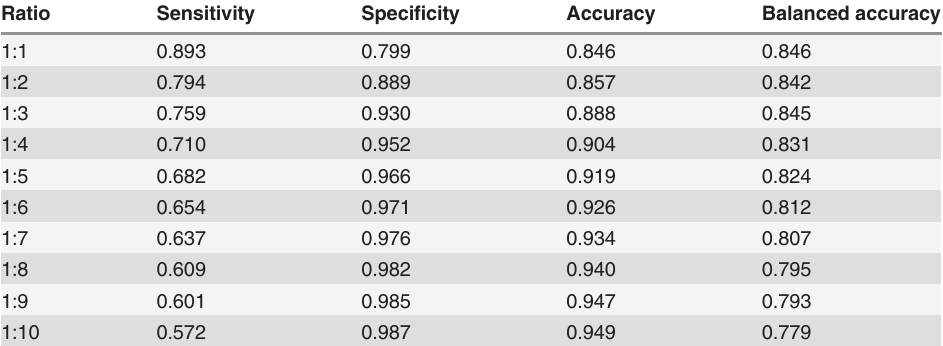
Table 3. The averaged performance with different ratios between positive and negative samples in the training set. The ratios of the number of positive samples to negative ones are from 1:1 to 1:10, respectively.